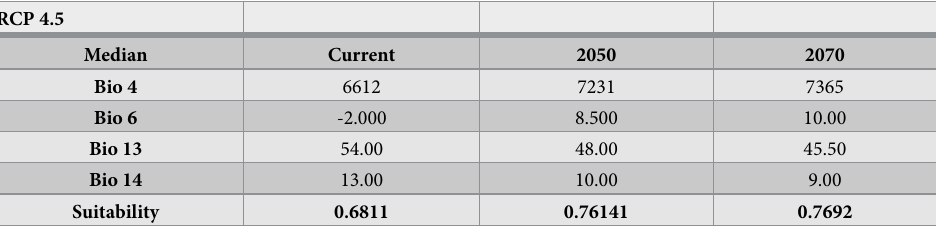
Table 3. Evolution of the median values for the selected bioclimatic variables under the RCP 4.5 scenario. The evolution of the medians of suitability are also shown in the bottom row. All the values are taken at the current loca- tions of G . bermejoi